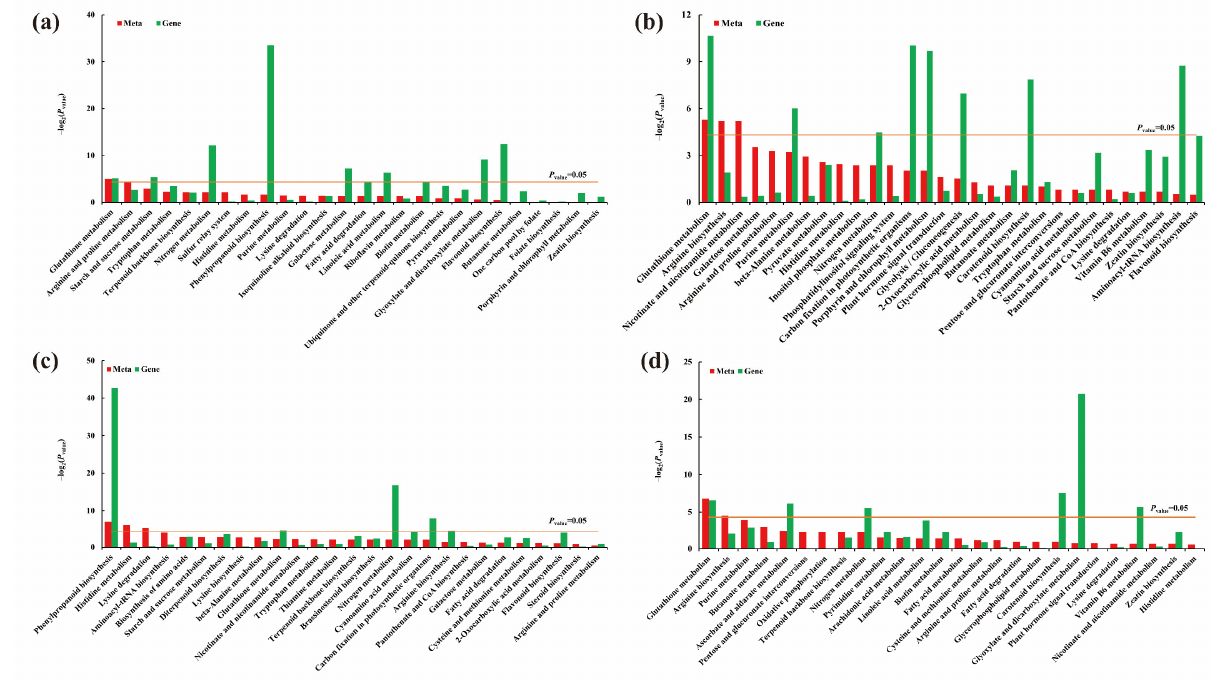
Figure 8. ( a ) Histograms of joint KEGG enrichment p value between DAMs and DEGS in leaves of W26; ( b ) histograms of joint KEGG enrichment p value between DAMs and DEGs in leaves of W20; ( c ) histograms of joint KEGG enrichment p value between DAMs and DEG S in roots of W26; ( d ) histograms of joint KEGG enrichment p value between DAMs and DEG S in roots of W20. “Meta” represents KEGG pathway enriched by DAMs, and “Gene” represents KEGG pathway enriched by DEGs. There is a significant difference above the yellow line ( p value < 0.05).